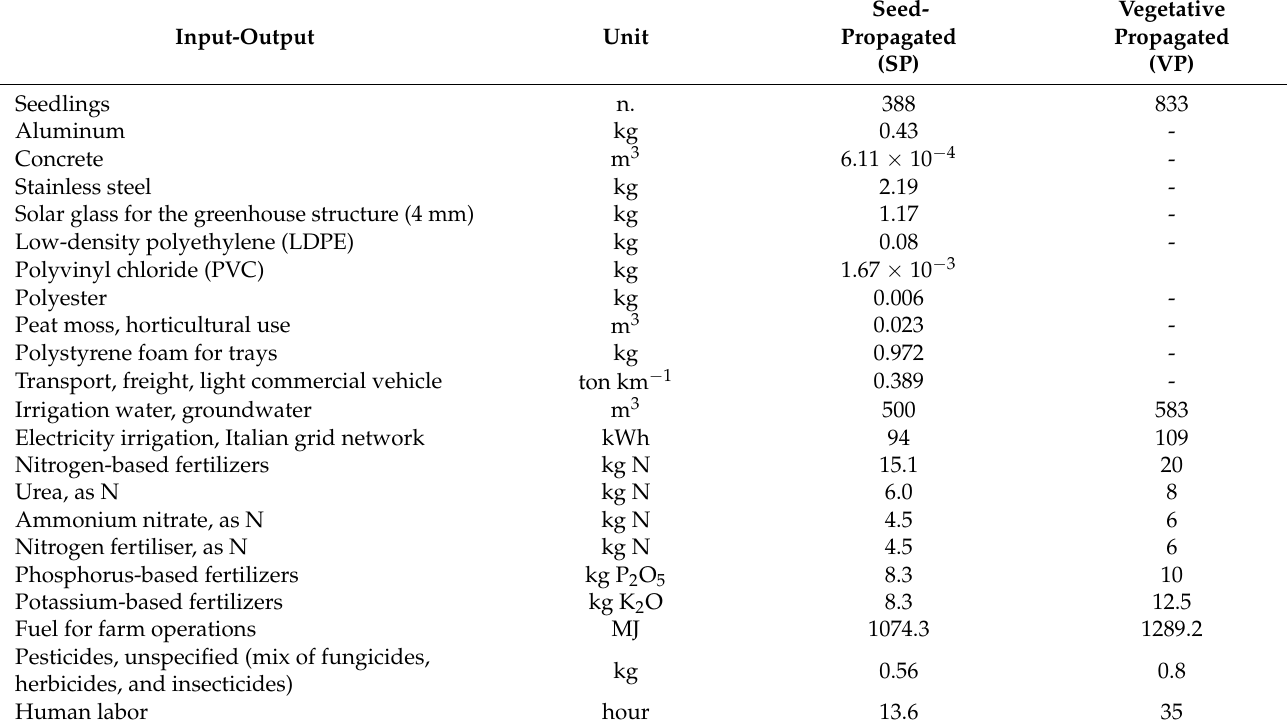
Table 2. Inventory input data for globe artichoke per 1 ton of artichoke heads at the farm exit